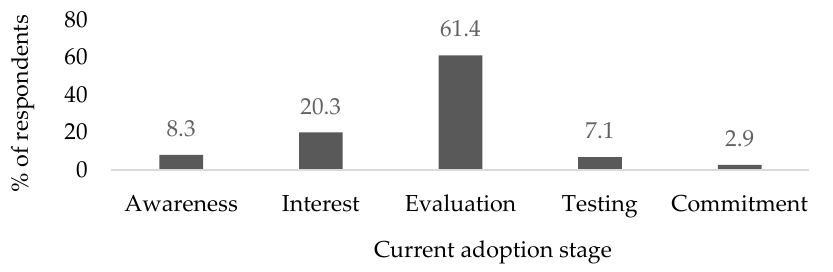
Figure 3. Stage of adoption of Cloud BI applications.